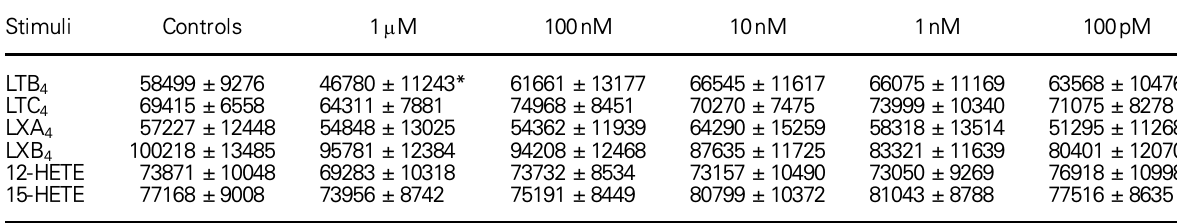
Table 3. Effects of lipoxygenase AA metabolites on [ 3 H]-thymidine incorporation of freshly isolated human mononuclear bone marrow cells. Experiments were made with marrow cells from 14 donors. Results (in dpm) are the mean ± SEM from four independent experiments in sixplicate ( n = 6)